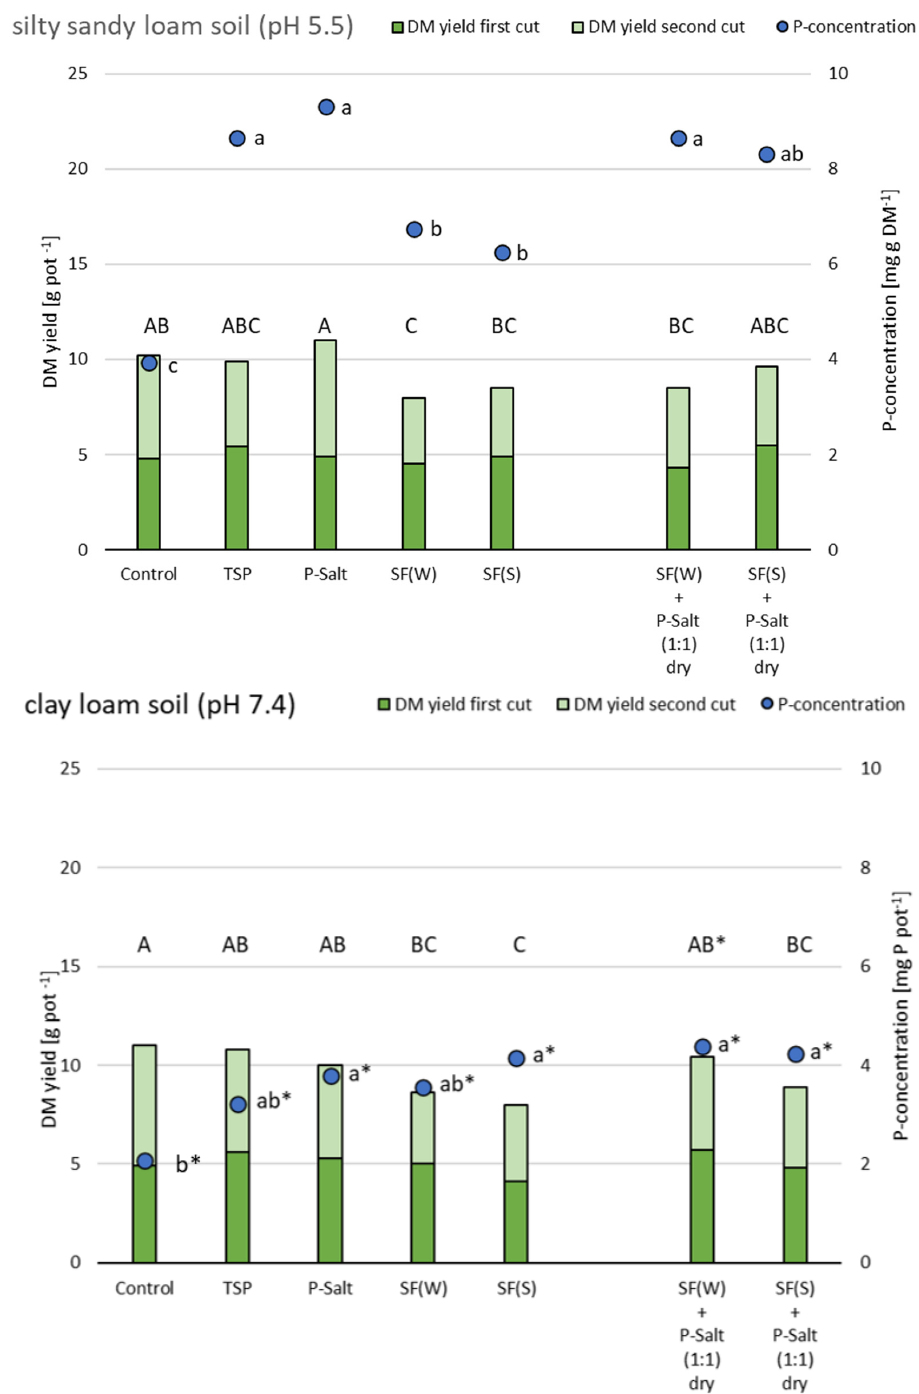
Figure 4. Total dry matter yield of ryegrass (DM yield) after 84 days in g pot − 1 , separated into first and second harvest, and ryegrass P concentration in mg P/g DM after soil treatment with different recycled digestate fertilizers in a total dose equivalent of 150 mg P (kg soil) − 1 ; fractions tested: P-Salt, SF(W), SF(S), and two different combinations of them, compared to unfertilized control and TSP. Based on the total fertilizer dose corresponding to 150 mg P (kg soil) − 1 , designation (1:1) means that fertilizers were applied with a mass portion of SF (W or S) containing 75 mg P (kg soil) − 1 + a mass portion of P-Salt containing 75 mg P (kg soil) − 1 . Data are means of four replicates each. Different letters denote significant differences (two factorial Tukey test with p ≤ 0.05), and significant differences between the soils are indicated by an asterisk